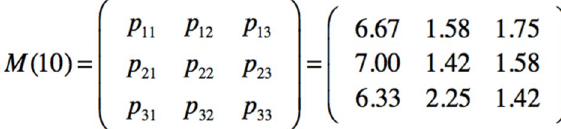
Figure 30. Number of visits for the posterior transition matrix.